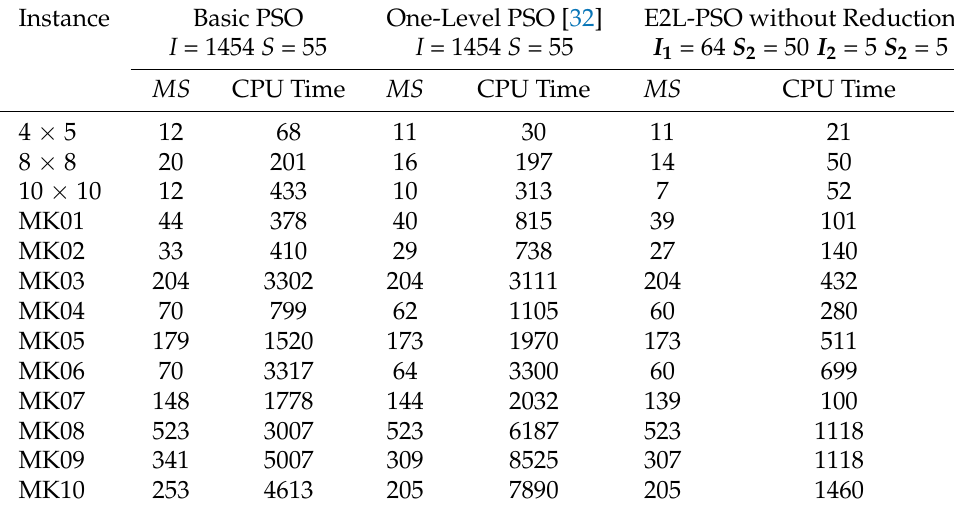
Table 5. Comparison 1 between the three developed PSO variants on STM32 F407VGT6.